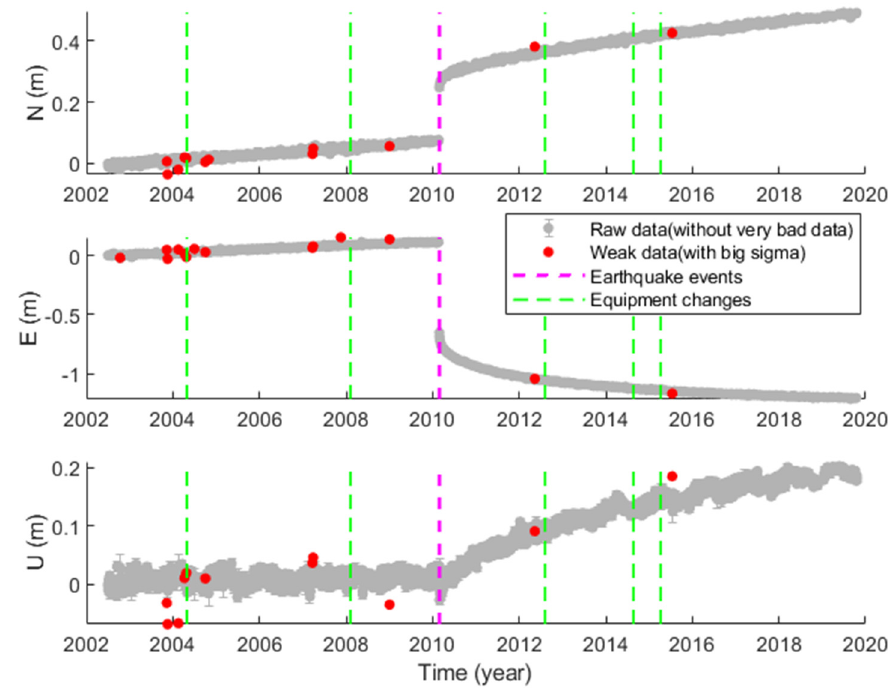
Figure 8. Preprocessing results of the raw coordinate time series.